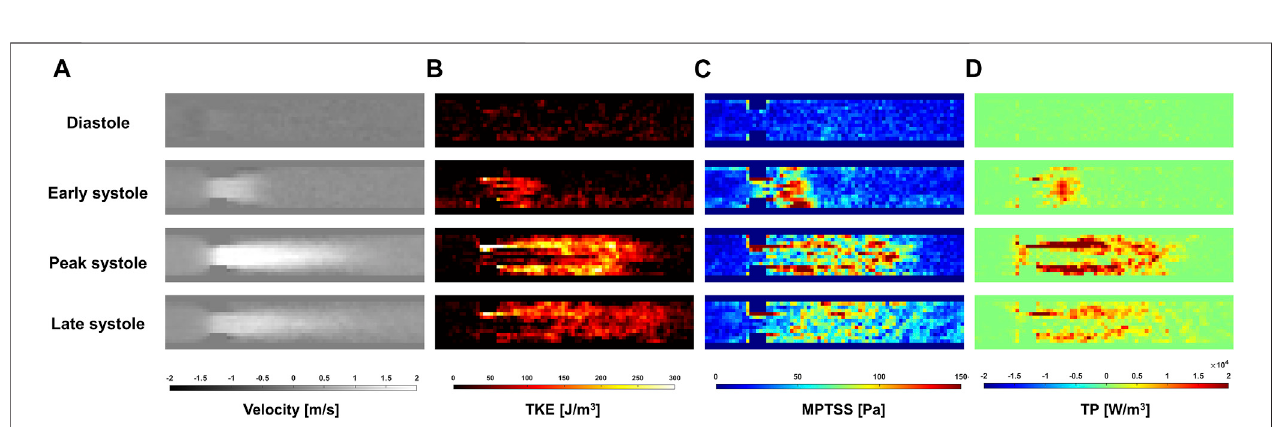
FIGURE4| Temporalvariationof (A) Velocity, (B) turbulentkineticenergy (TKE), (C) maximumprincipalturbulent shearstress(MPTSS), (D) turbulence production (TP) through the stenosis at Venc of 200 cm/s.